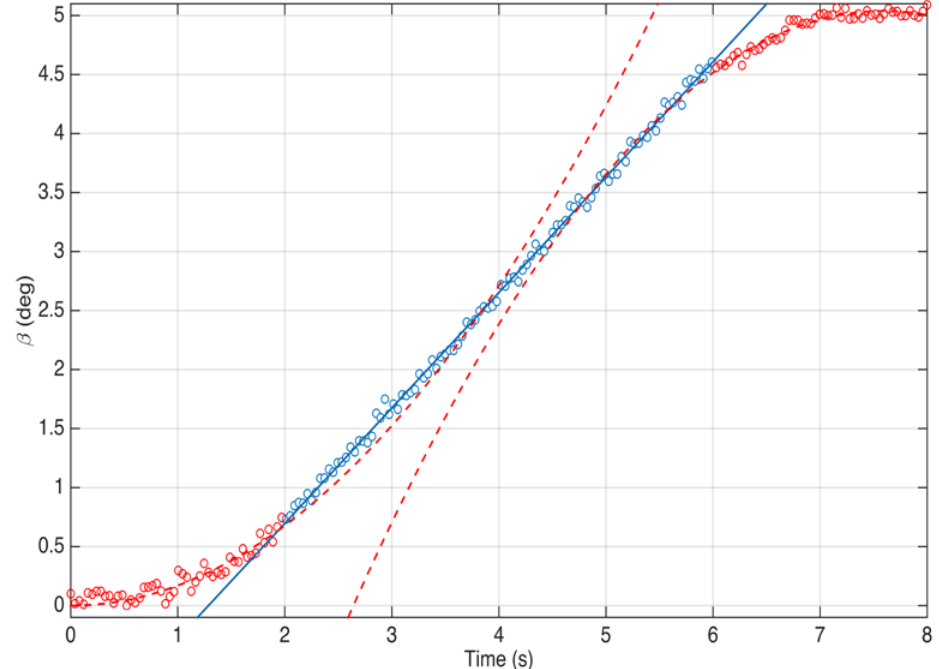
Figure 8. Variation in time of the orientation of the computed bisector for the selected segments from the rotation stage experiment. The curve was divided into three, approximately distinguishing between the linear (blue circles) and nonlinear parts (red circles). The blue line and the red dashed lines represent the best curve fitting to each